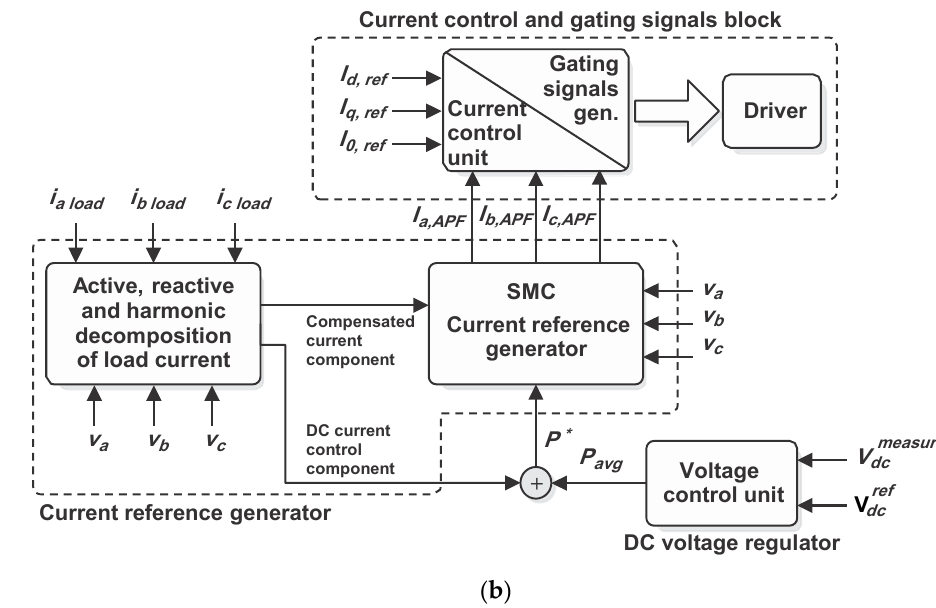
Figure 3. HAPF scheme; ( a ) Shunt APF with series in passive filter, ( b ) control diagram.